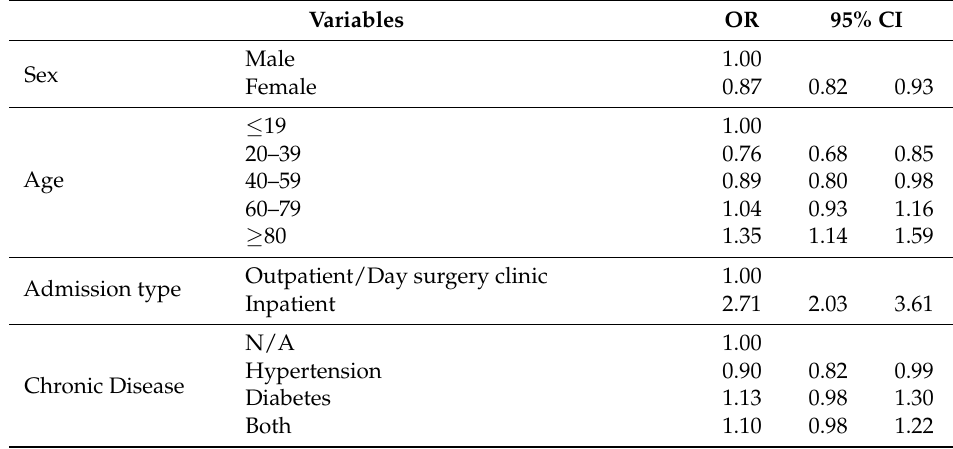
Table 3. Multivariable regression of the association with surgery cancellation and related factors (All